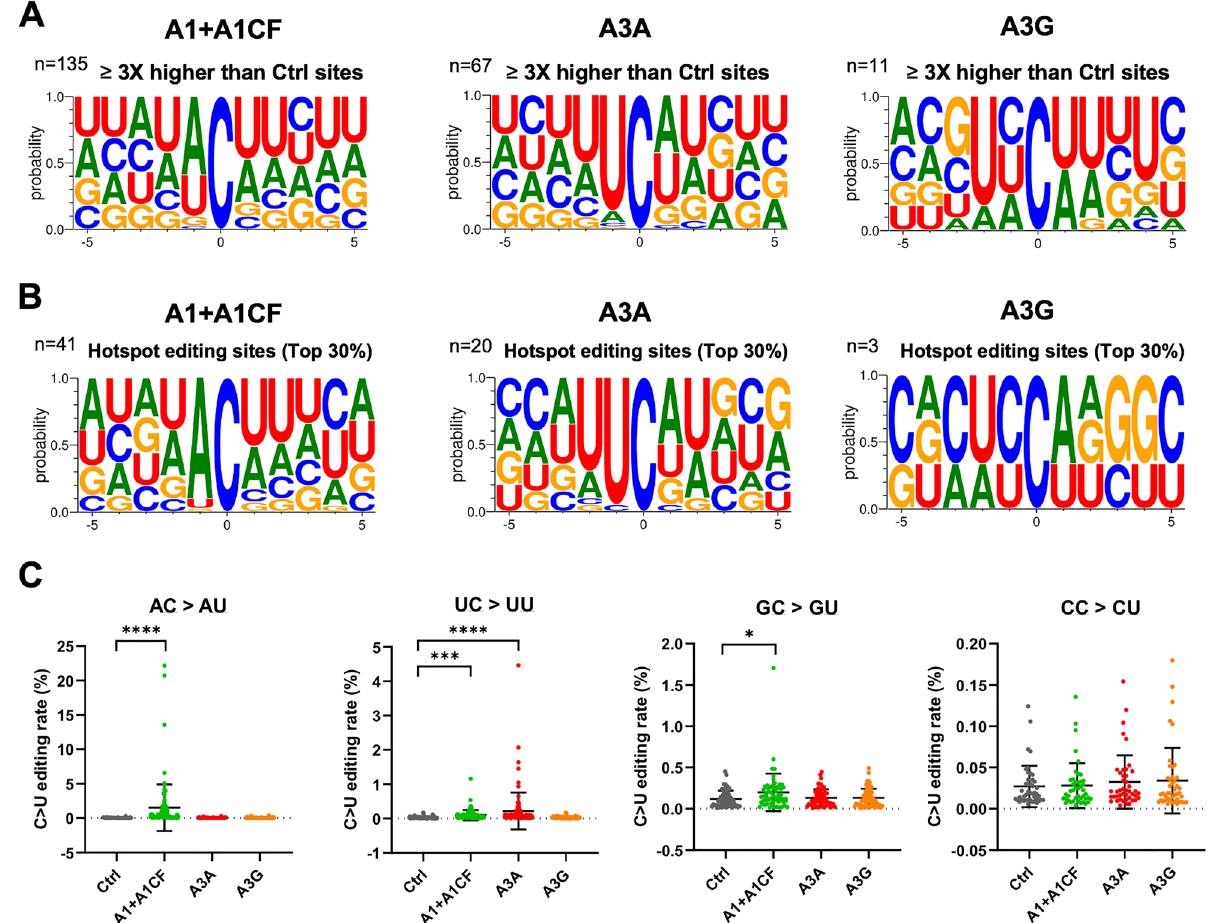
Figure 2. Local sequence context at the APOBEC-edited C sites on SARS-CoV-2 RNA. ( A ) Local sequences around the significantly edited target C sites (± 5 nucleotides from target C at position 0) by A1 + A1CF, A3A, or A3G. The editing level of each C site was normalized to the Ctrl, and only sites with 3 × or higher editing levels than the normalized value were defined as significant editing sites. ( B ) Analysis of local sequences around the top 30% edited C sites (or hotspot editing sites), showing predominantly AC motif for A1 + A1CF, UC for A3A, and CC for A3G. ( C ) Comparison of the C-to-U editing rates (%) of a particular dinucleotide motif by the three APOBECs. Each dot represents the C-to-U editing level obtained from the SSS results. In panel-D, statistical significance was calculated by unpaired two-tailed student’s t-test with P -values represented as: P > 0.05 = not significant; not indicated, *P < 0.05, ***P < 0.001, ****P <